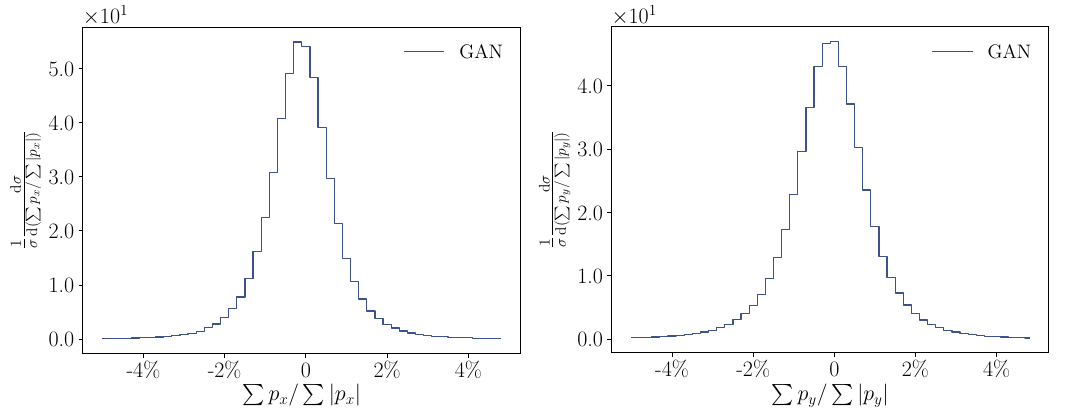
Figure 8: Sum of all p ( p ) momenta divided by the sum of the absolute values in x y the left (right) panel, testing how well the GAN learns momentum